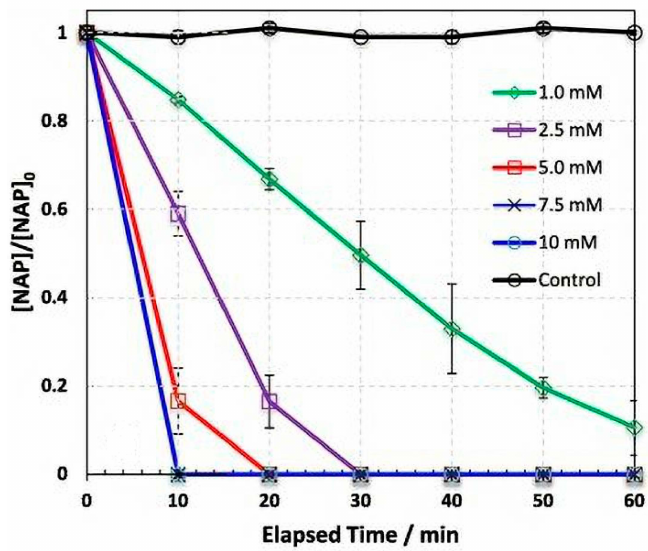
Figure 5. Evolution of naproxen concentration as function of the elapsed time during the treatment of hospital effluents. [NAP]0 = 50 µ Ì M, pH 7.50, T = 70 ◦ C. Reprinted with permission from ref. [56]. Copyright 2015